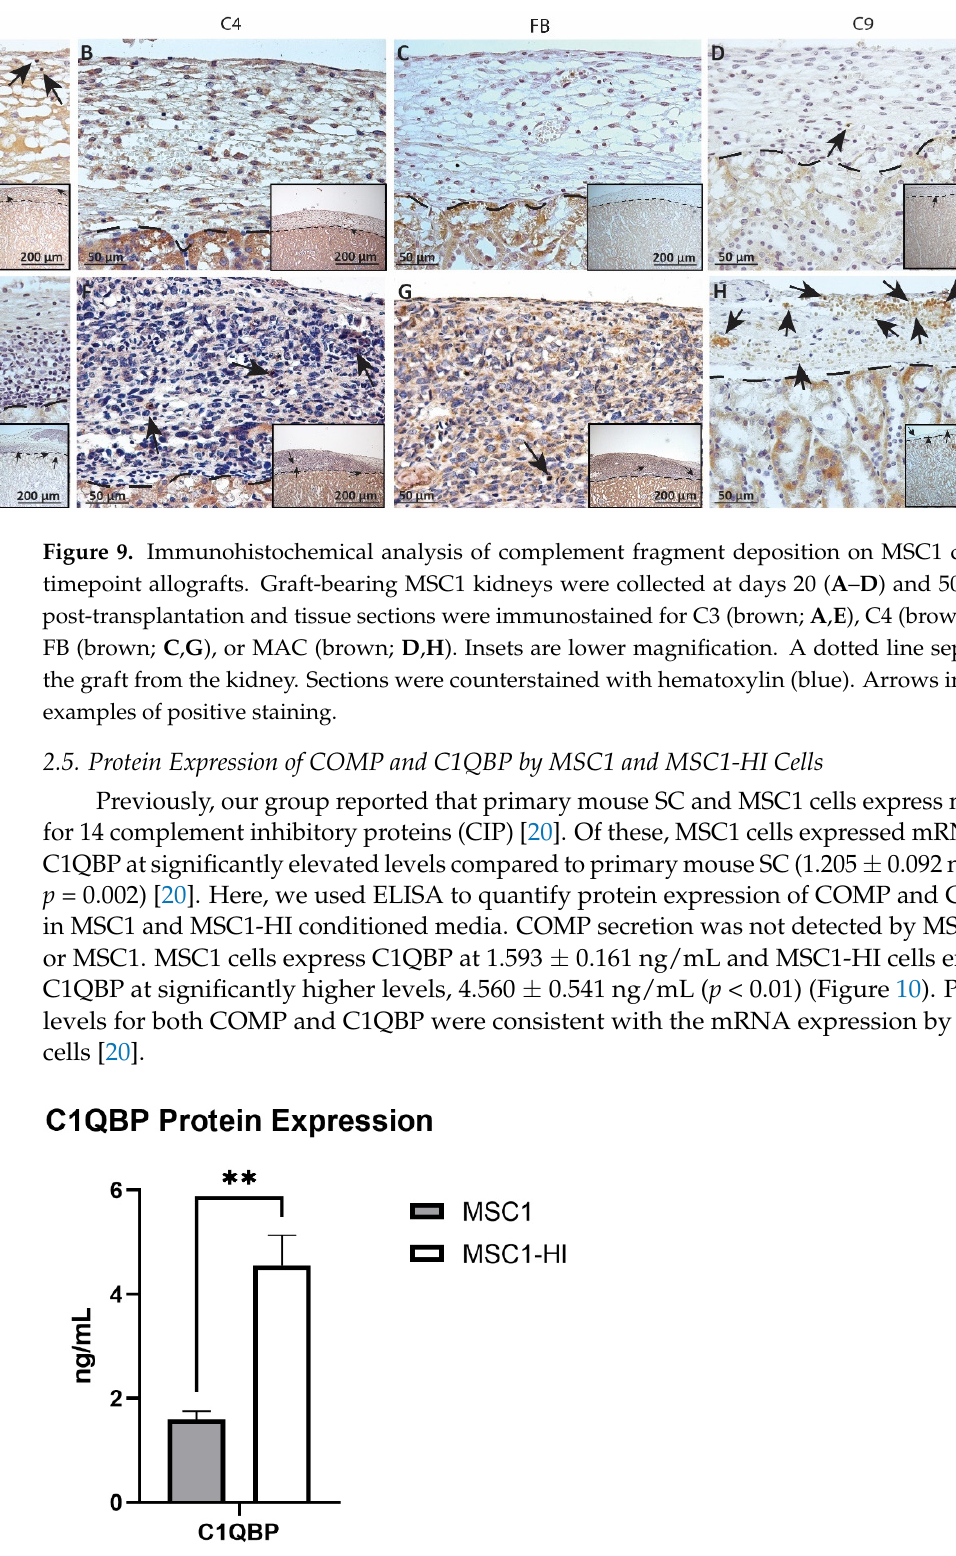
Figure 8. Immunohistochemical analysis of complement fragment deposition on MSC1-HI chronic timepoint allografts. Graft-bearing MSC1-HI kidneys were collected at days 20 ( A – D ) and 50 ( E – H ) post-transplantation and tissue sections were immunostained for C3 (brown; A , E ), C4 (brown; B , F ), FB (brown; C , G ), or MAC (brown; D , H ). Insets are lower magnification. A dotted line separates the graft from the kidney. Sections were counterstained with hematoxylin (blue). Arrows indicate ex- amples of positive staining.